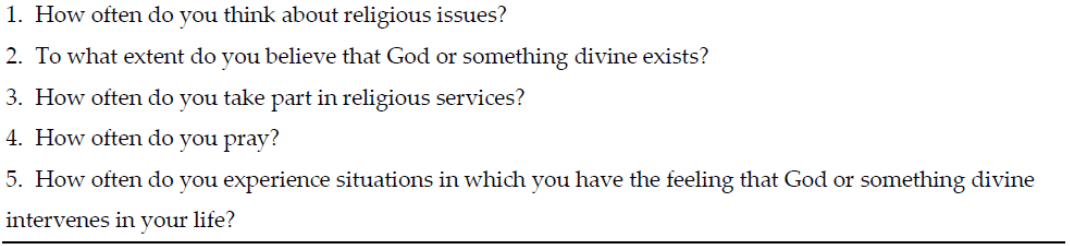
Figure 3. Dimensions of the concept of ‘religiosity’.